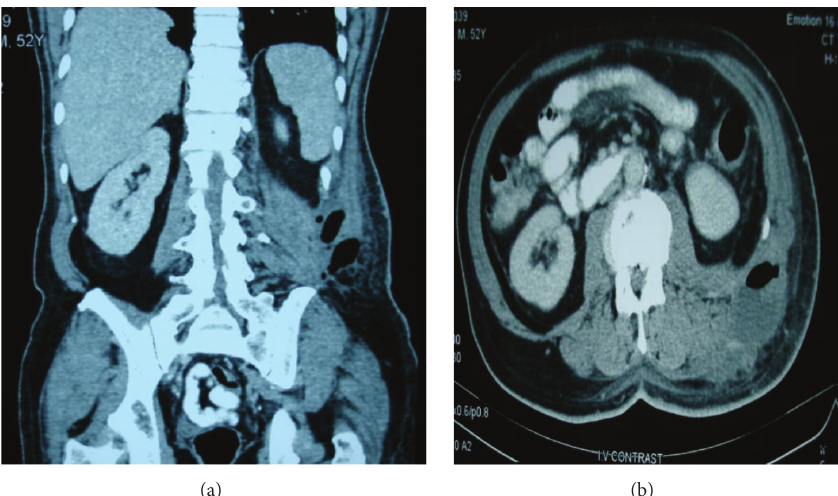
Figure 3: Abdominal CT scans revealed a perforated diverticulitis of the sigmoid colon causing subcutaneous inflammation and free gas in the tissue of the posterior abdominal wall and lumbar area.